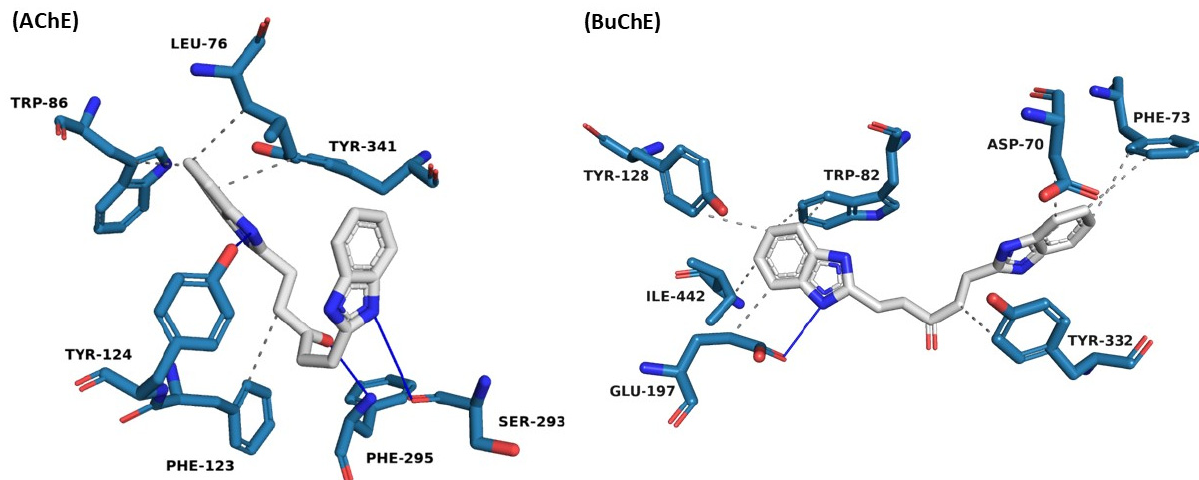
Figure 7. ZINC04541733 interactions at AChE and BuChE binding sites obtained from the repre- sentative structure of the MD simulation. White: ligand carbons; blue: nitrogen; red: oxygen; white sphere: aromatic center; solid blue line: hydrogen bond; gray dashed line: hydrophobic interaction.